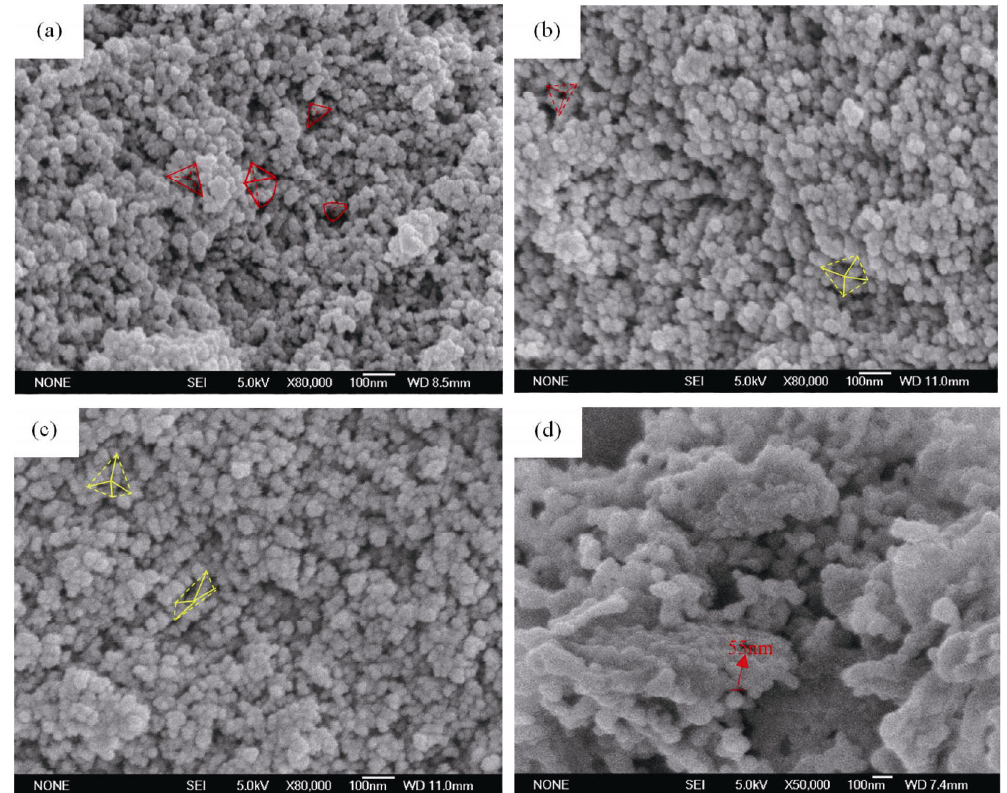
Fig. 7 SEM images of SiO 2 aerogels calcined at different temperatures: (a) room temperature; (b) 600 ℃ , 2 h; (c) 800 ℃ , 2 h; (d) 1000 ℃ , 2 h. Graphics in red stand for tetrahedron, yellow for